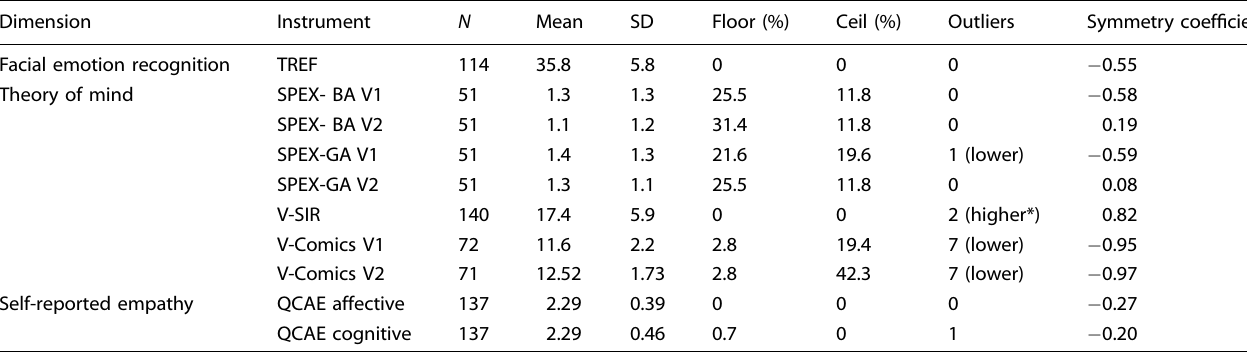
Table 2. Psychometric characteristics of social cognition measures.